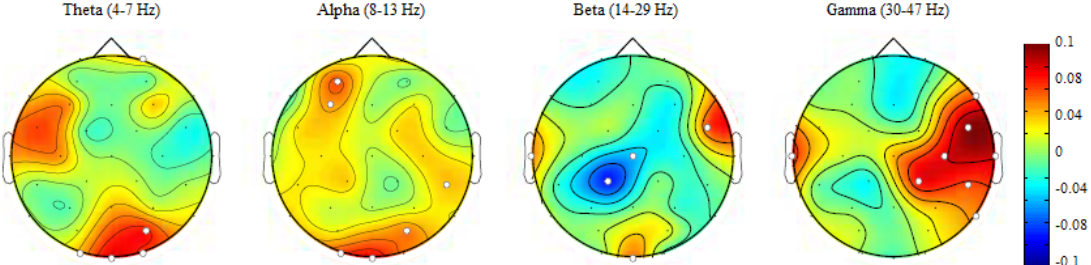
Figure 5. The average correlations for all subjects of the valence ratings with the power of different frequency bands. The highlighted electrodes correlate significantly ( p < 0.05) with the valence ratings. c (cid:13) [2011] IEEE. Reprinted, with permission, from: IEEE Trans. Affect. Comput., DEAP: A Database for Emotion Analysis Using Physiological Signals, Mühl, C.; Lee, J.s.